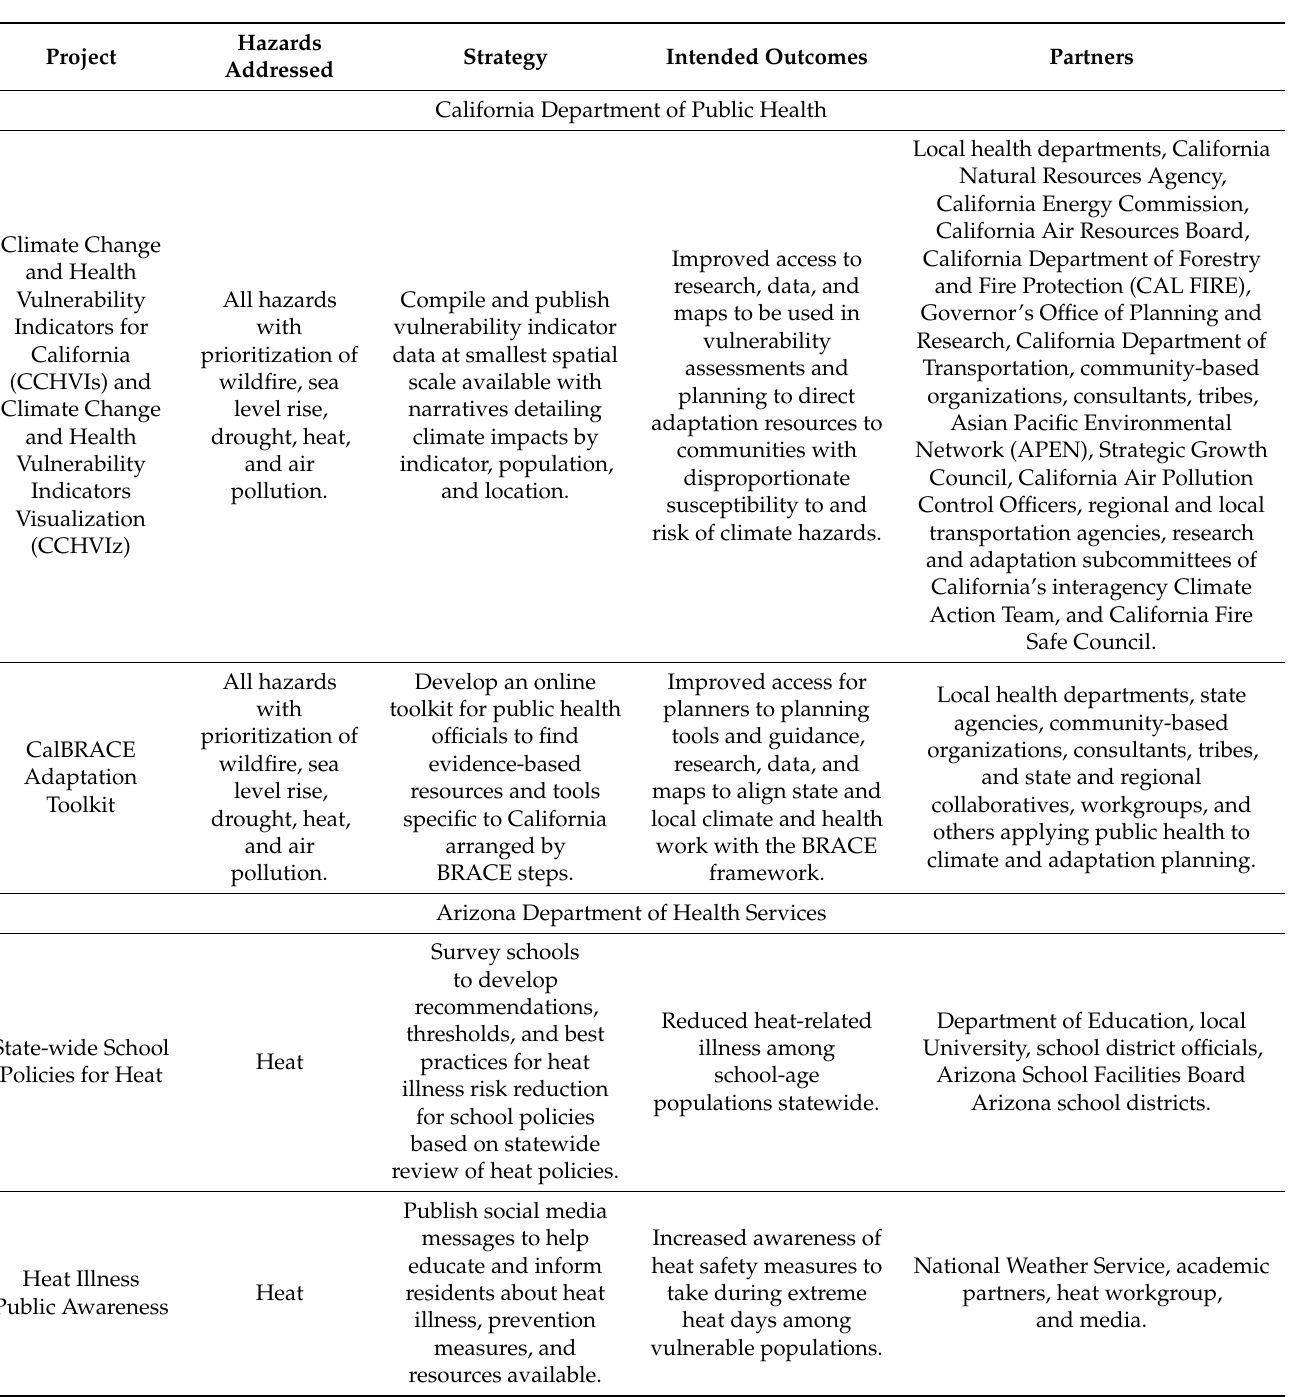
Table 1. Eleven projects implemented by CRSCI grantees determined to be successful in achieving objectives in climate and health